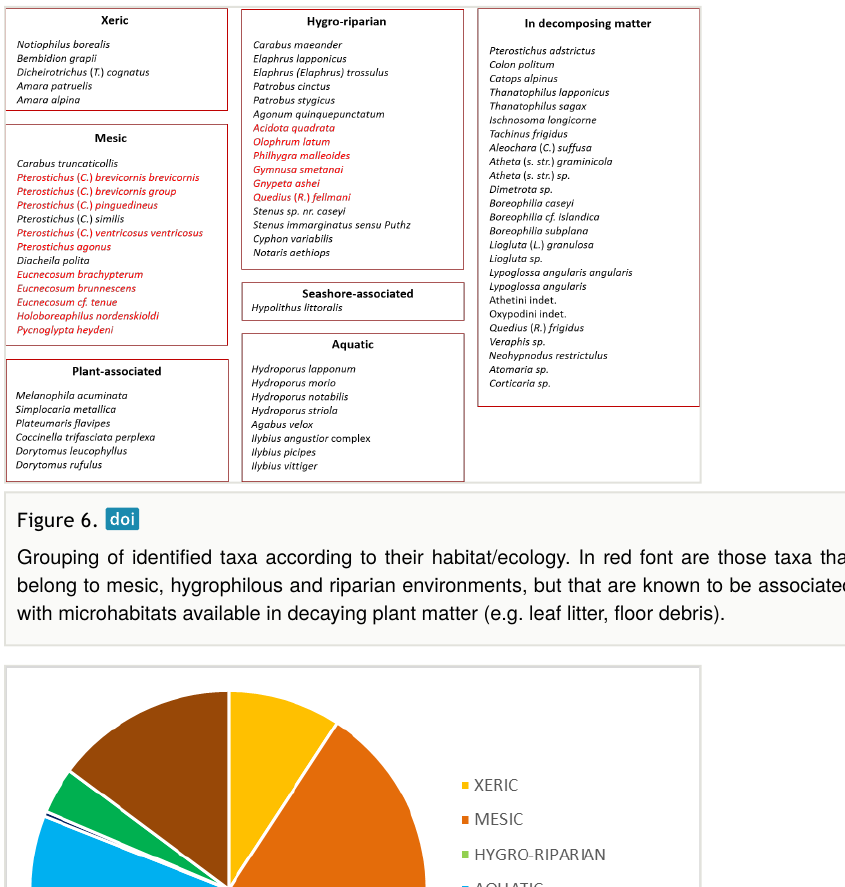
plant matter (DSS, unpublished data). The ‘Plant-associated’ group includes taxa that feed directly on plants, but also the predator Coccinella trifasciata perplexa Mulsant, which preys on arthropods closely associated with plants (cf. Matthews 1983).